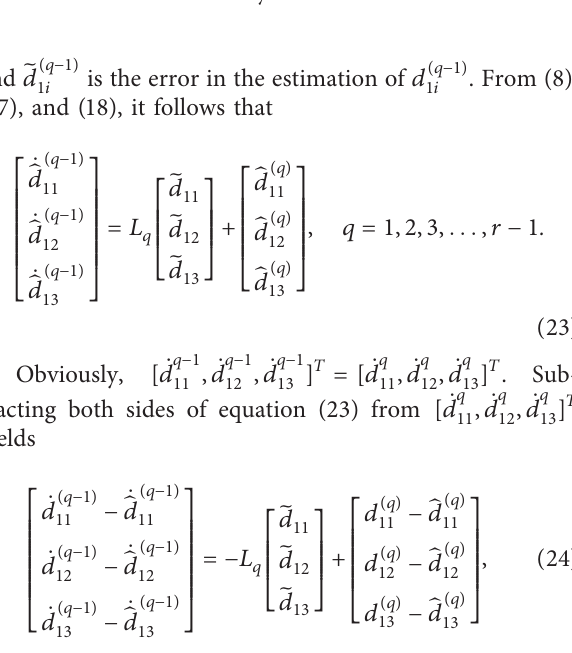
Figure 1: Control system with the